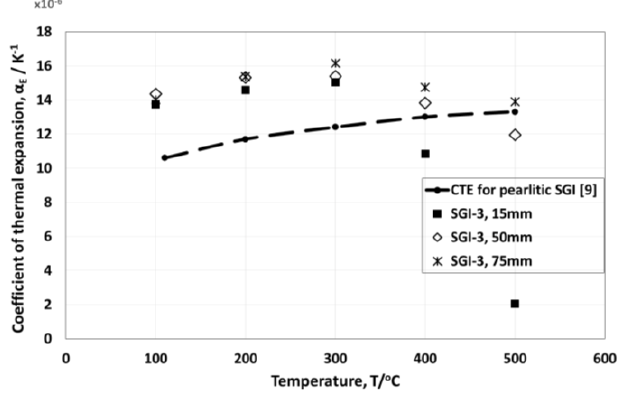
Figure 8. Coefficient of thermal expansion (CTE) of SGI-3 (15, 50 and 75 mm) as a function of temperature (during heating